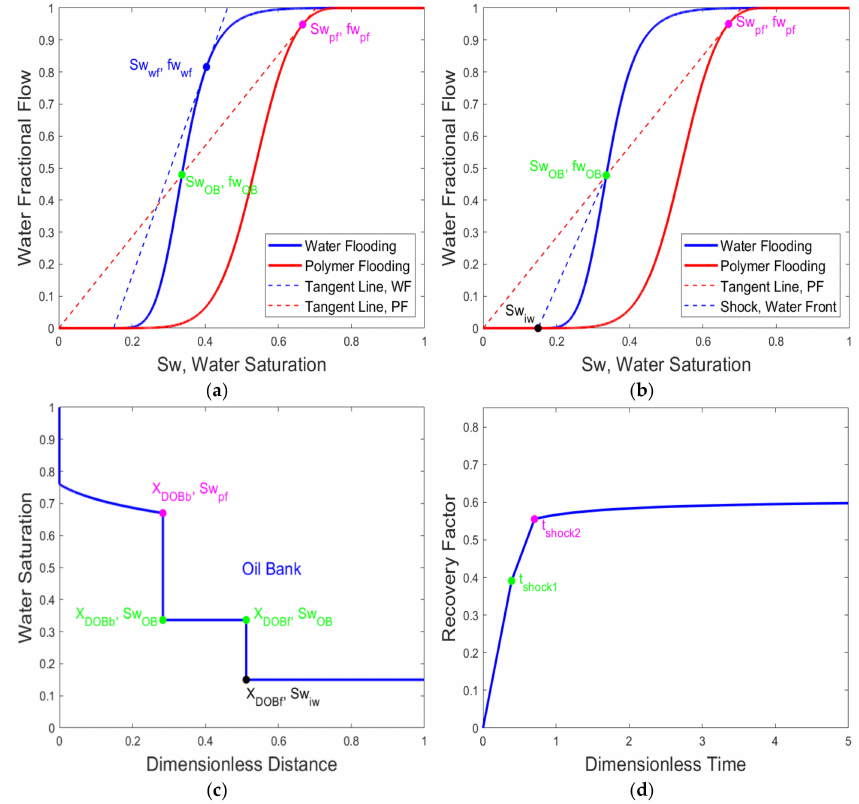
Figure 18. ( a ) Comparison of shock front for water flooding and polymer flooding; ( b ) Construction of shock front during secondary recovery by polymer flooding; ( c ) Water saturation profile at t D = 0.2 PV during continuous polymer injection; and ( d ) Cumulative oil recovery history during secondary recovery by polymer